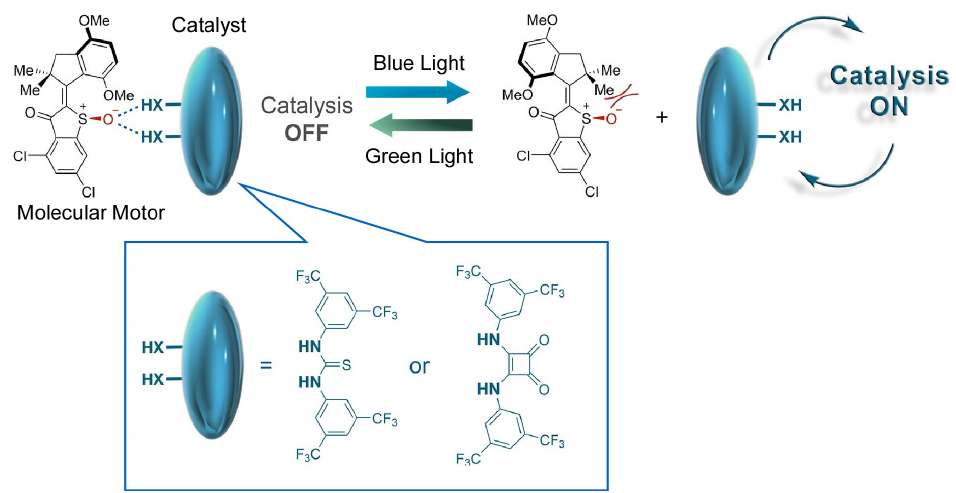
Figure 6. Light-induced shape changes of a hemithioindigo-based molecular motor to control the efficiency of a hydrogen-bonded organocatalysts. Reprinted with permission from Reference [132].